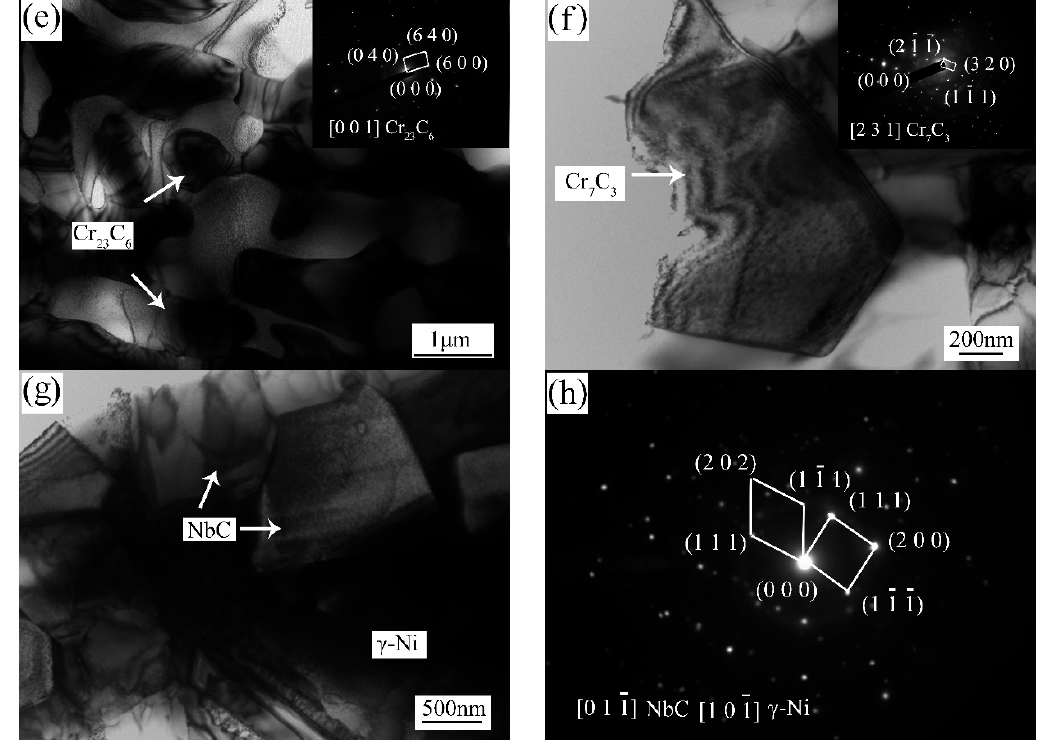
Figure 6. Transmission electron microscopy (TEM) images and selected area diffraction patterns (SADP) of coating with P4 ( a ) TEM image, ( b ) SADP of ( a ), ( c ) Cr 5 B 3 , ( d ) CrB, ( e ) Cr 23 C 6 , ( f ) Cr 7 C 3 , ( g ) NbC, ( h ) SADP of ( g ).